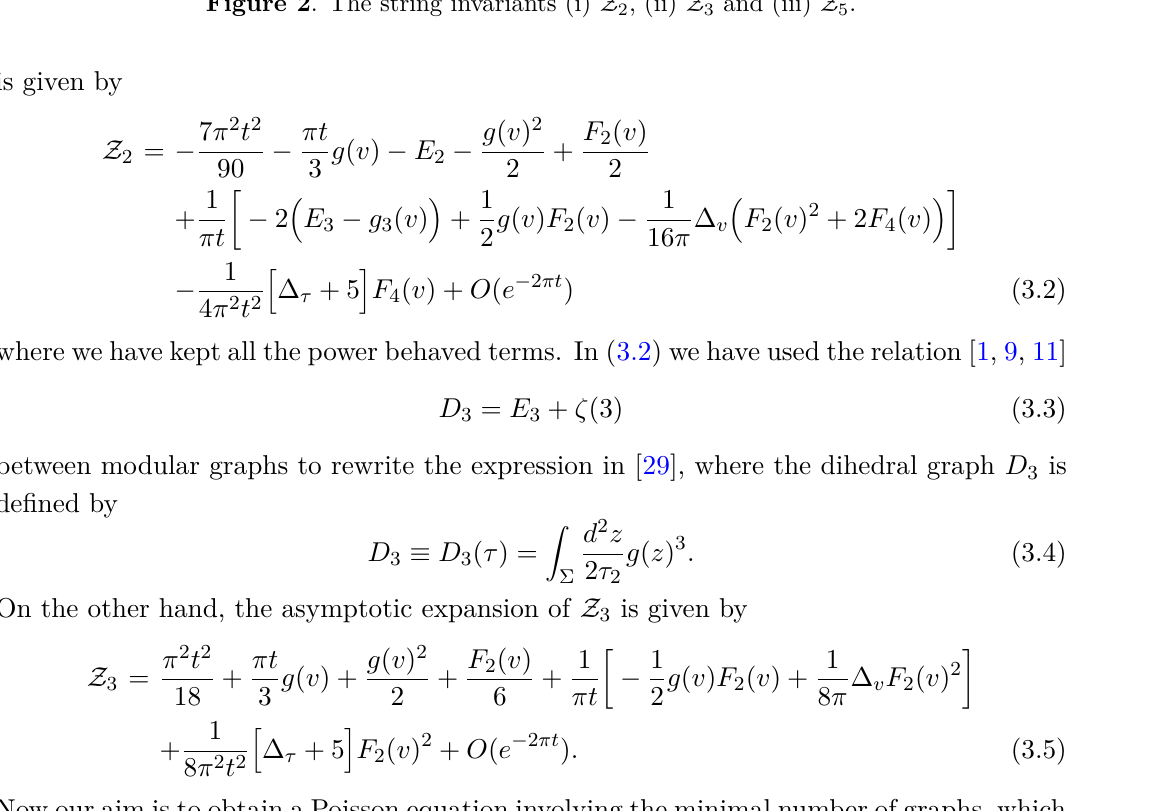
Figure 2 . The string invariants (i) Z 2 , (ii) Z 3 and (iii) Z 5